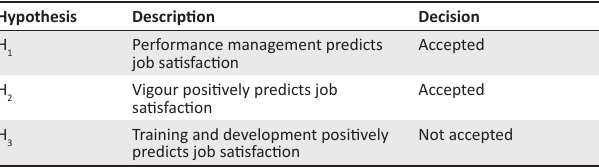
TABLE 4: Hypothesis